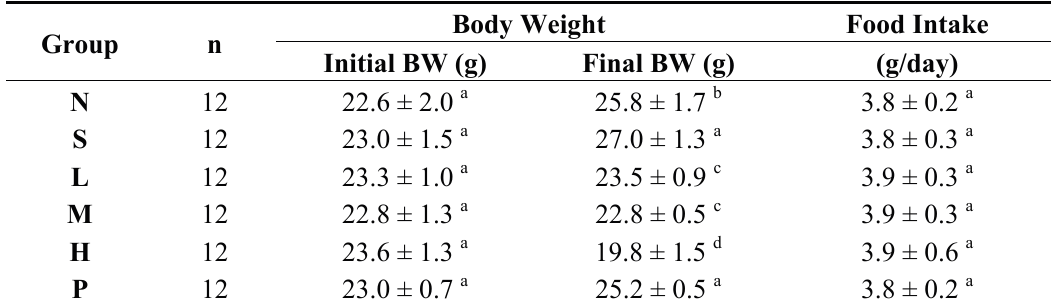
Table 1. Initial body weight, final body weight, and food intake for